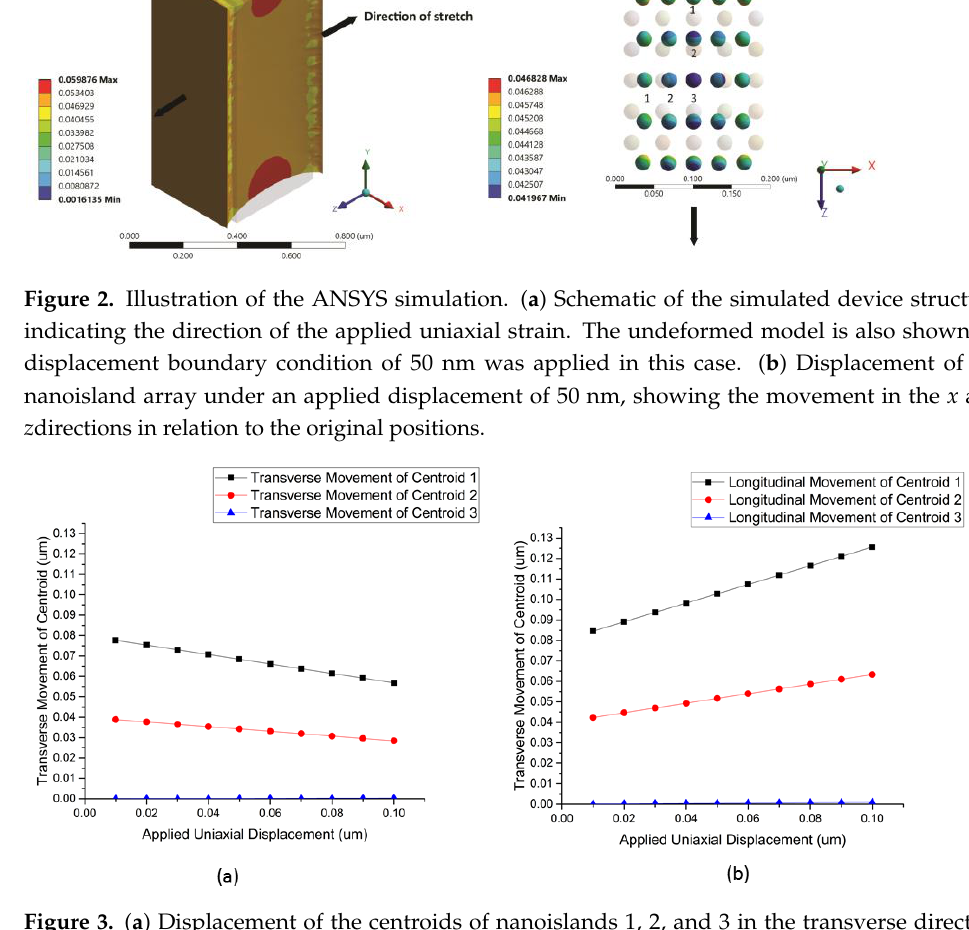
Figure 2. Illustration of the ANSYS simulation. ( a ) Schematic of the simulated device structure, in- dicating the direction of the applied uniaxial strain. The undeformed model is also shown. A dis- placement boundary condition of 50 nm was applied in this case. ( b ) Displacement of the nanois- land array under an applied displacement of 50 nm, showing the movement in the x and z direc- tions in relation to the original positions.